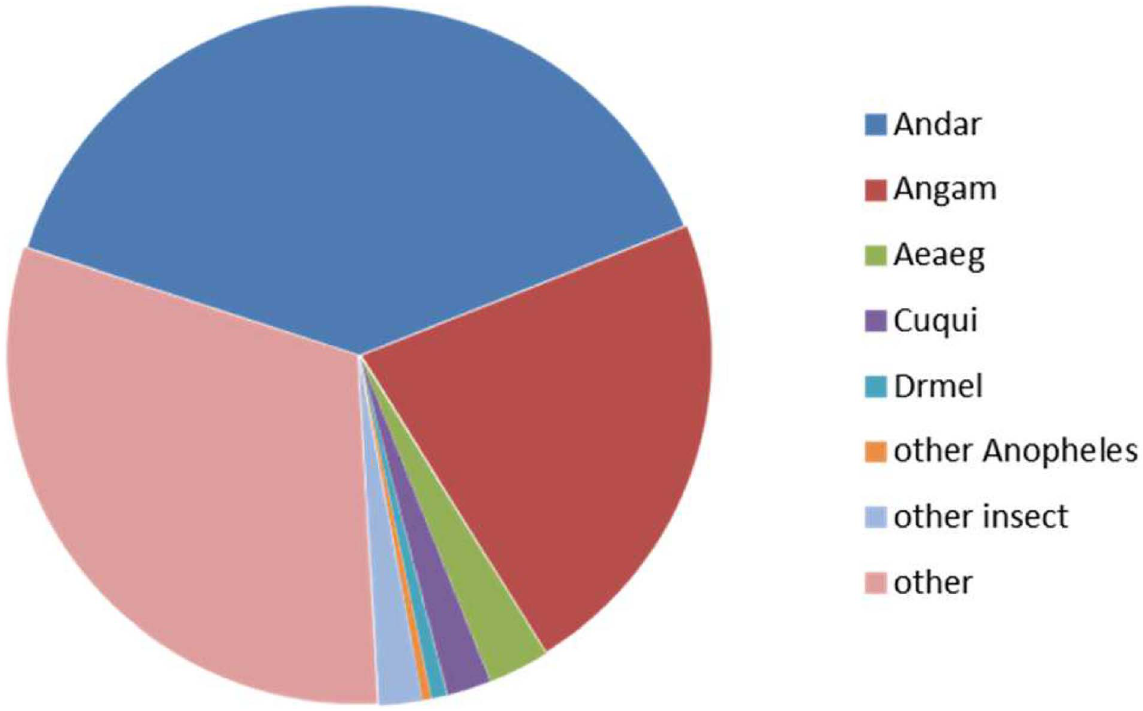
Figure 2. Distribution of the best matches of all An.aquasalis predicted proteins by organisms: Andar- An.darlingi ; Angam- An. gambiae ; Aeaeg, Ae.aegypti ; Cuqui, Cu.quinquefasciatus ; Drmel, D.melanogaster ; Other Anopheles species; Other insects- not of the Anopheles genus; Other- non-insect organisms.